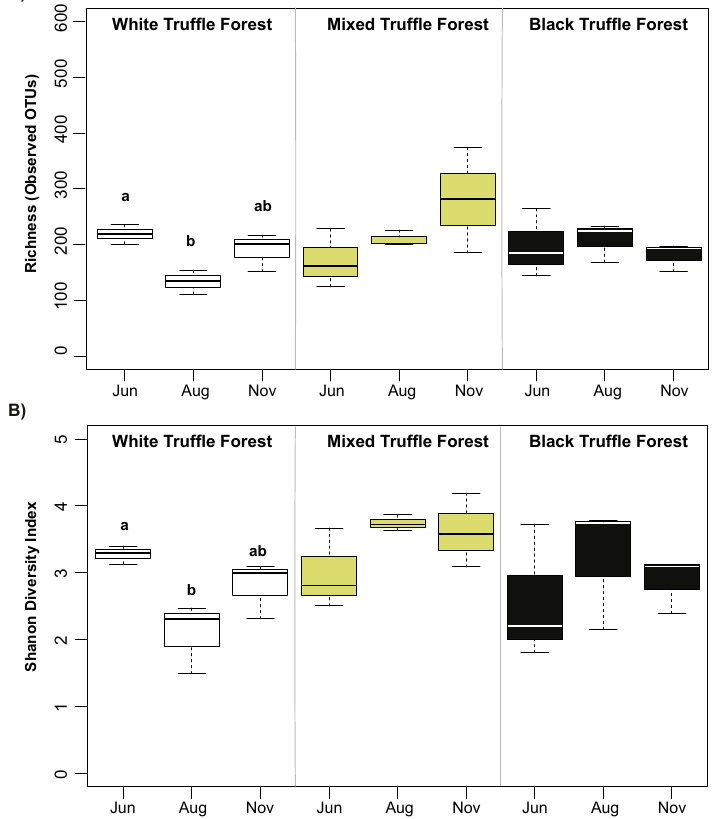
Figure 2. Observed richness (number of OTUs) ( A ) and Shannon diversity index ( B ) of root-associated mycobiome in white, mixed, and autumn black truffle-producing forest across three different sampling months (June, August, and November) in Serbian riparian forests. Significant differences in observed richness and Shannon diversity Index between different truffle-producing forests were calculated using one-way ANOVA followed by Tukey’s HSD test ( p > 0.05).